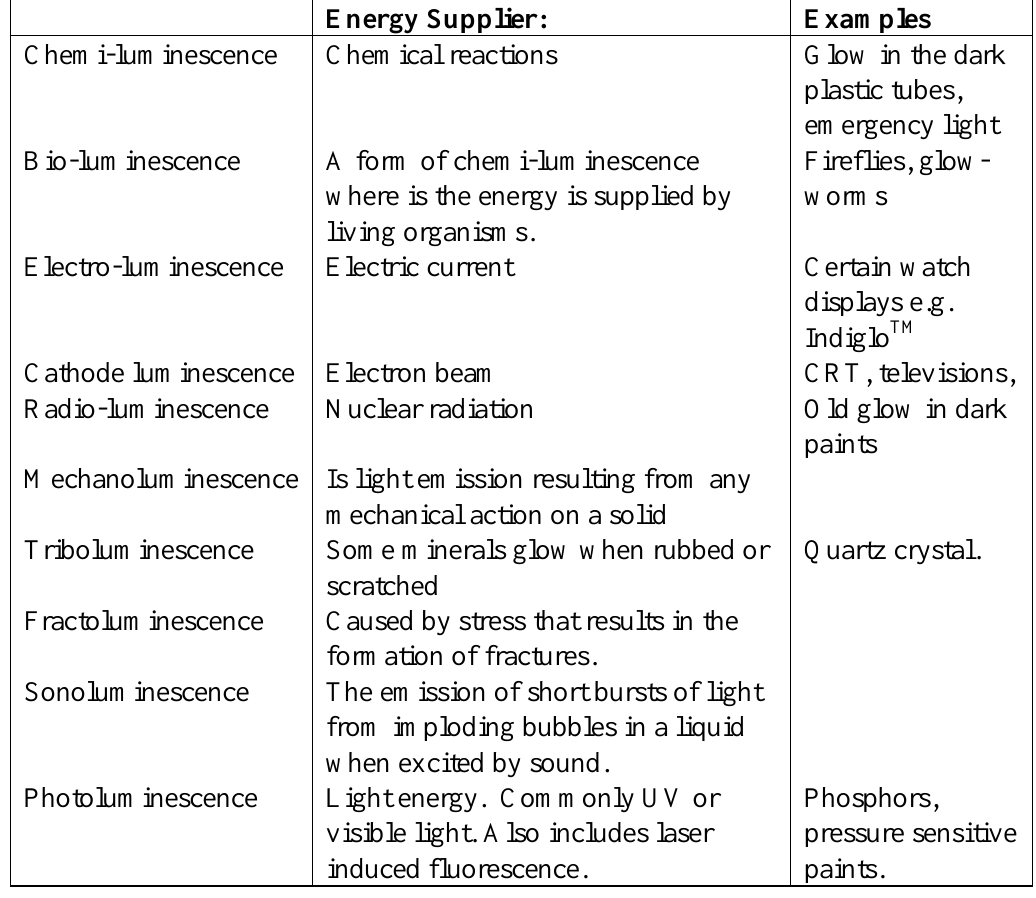
Table 1. Examples of various types of